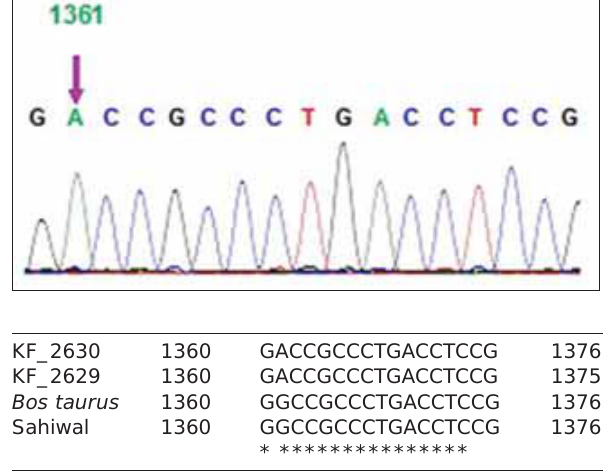
Figure-3: Chromatogram showing nucleotide change at